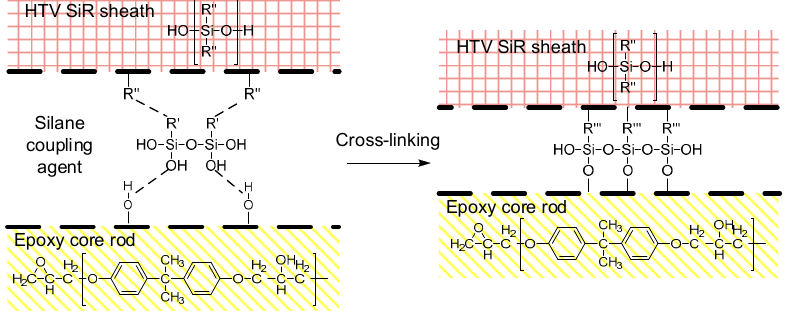
Figure 8. Mechanism of silane coupling agent in bonding the core rod and HTV SIR sheath of composite insulator.